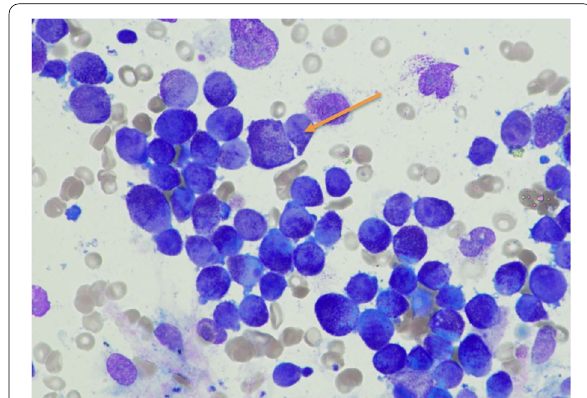
50 Power): Hypercellular ×